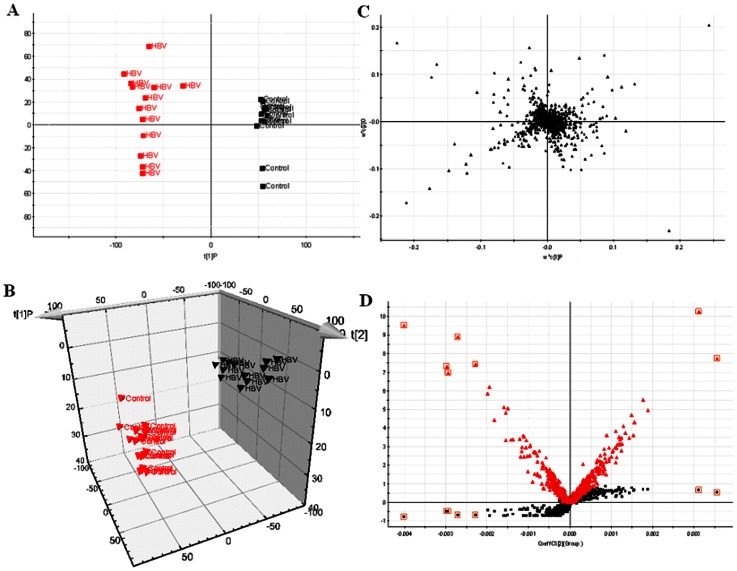
Metabolomic profiling of HBV.OPLS-DA model results for HBV group in positive mode (A). 3-D of OPLS-DA model for HBV group (B). Loading plot of OPLS-DA of HBV in positive mode (C). Panel D shows the combination of S- and VIP-score plots constructed from the supervised OPLS analysis of urine (ESI+ mode). Ions with the highest abundance and correlation in the HBV group with respect to the controls are present on the upper far right hand quadrant, whereas ions with the lowest abundance and correlation in the HBV group with respect to the control group are residing in the lower far left hand quadrant.